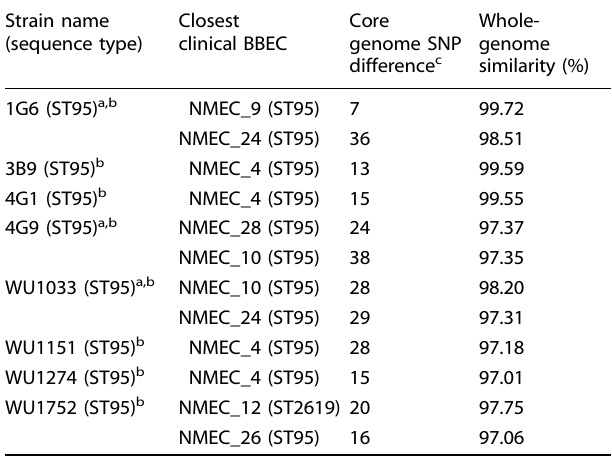
Table 2. Pairwise whole genome similarity and core genome SNP distance matrix of W-ExPEC strains and their closest clinical NMEC